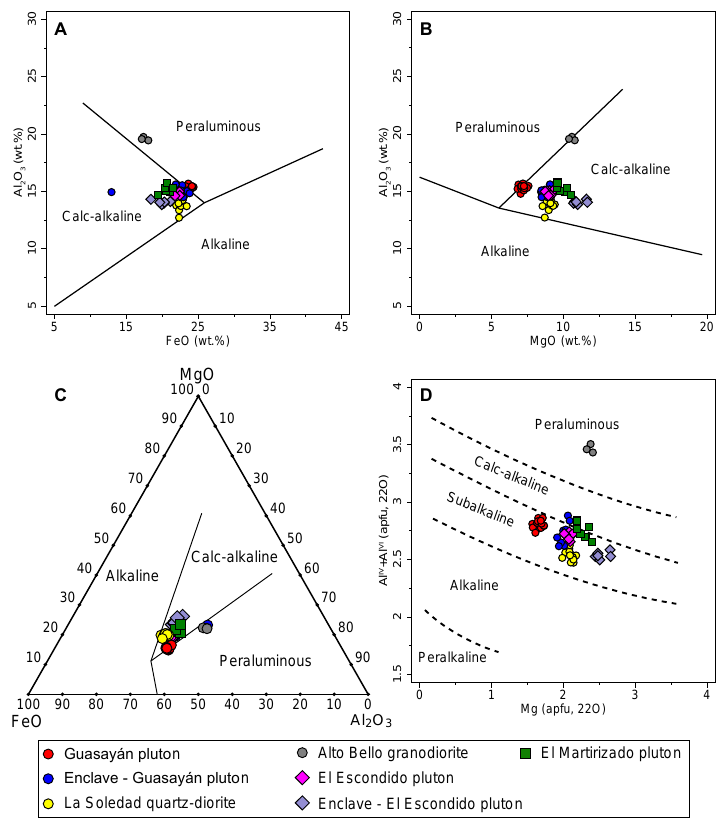
Figure 9. Composition of biotites from the granitoids of the Sierra de Guasay á n. Al 2 O 3 vs. FeO ( A ), Al 2 O 3 vs. MgO ( B ) and MgO–FeO–Al 2 O 3 ( C ) discrimination diagrams (after [12]) and Al IV + Al VI vs. Mg diagram ( D ) (after